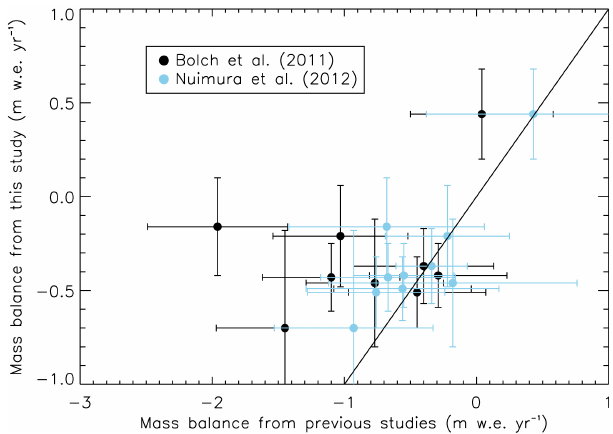
Fig. 12. Comparison of geodetic mass balances for 10 glaciers in the Mount Everest area. 1999–2010 mass balances measured in the present study are compared with published estimates during 2002–2007 (Bolch et al., 2011) and during 2000–2008 (Nuimura et al., 2012). The 1-to-1 line is drawn. The mean difference ( ± 1 standard deviation) between (i) our values and Bolch et al. (2011) are (0.47 ± 0.58mw.e.yr − 1 ) and (ii) our values and Nuimura et al. (2012) are (0.12 ± 0.21mw.e.yr − 1 ) . Part of the differences be- tween estimates may be due to the different periods surveyed and the different glacier outlines